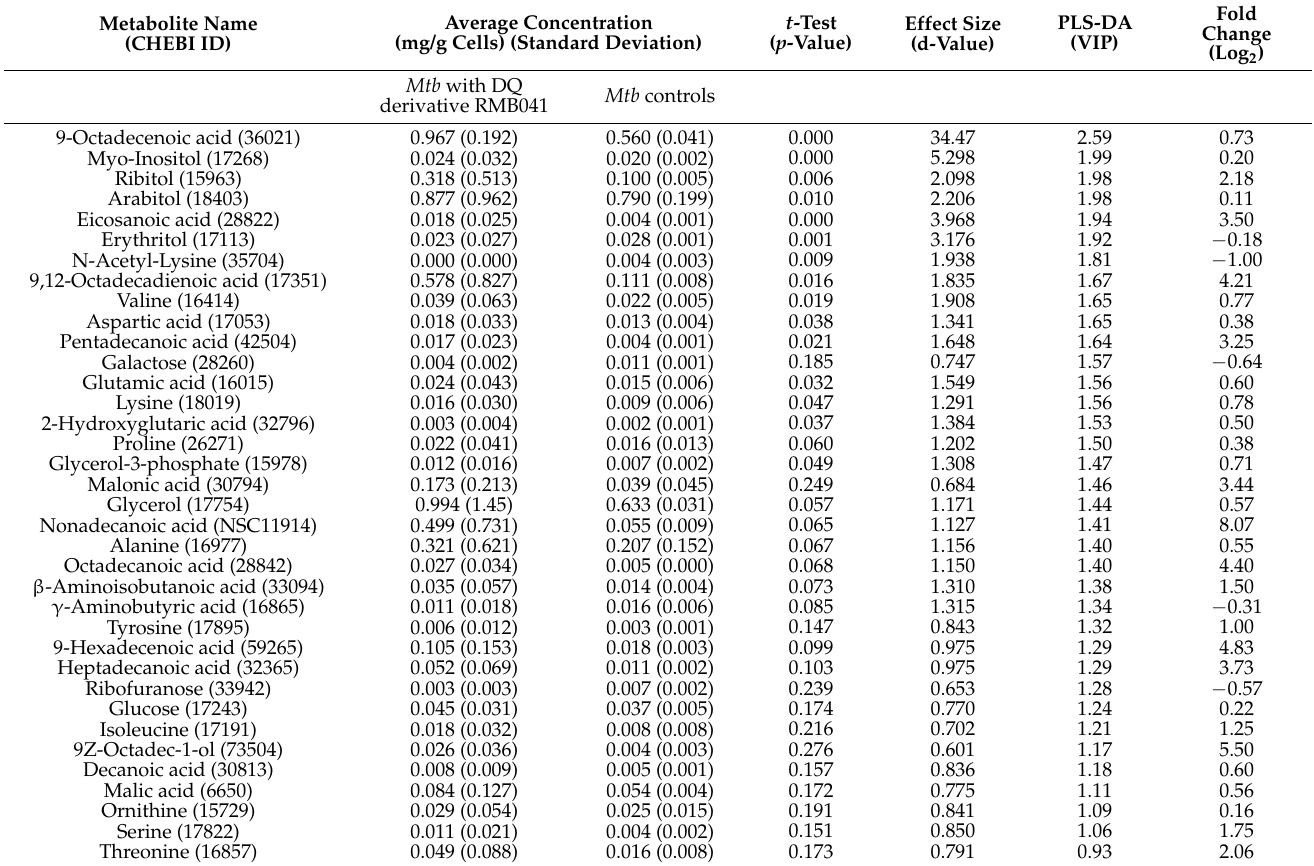
Table 1. The selected metabolite markers best describing the variance between the metabolome of Mtb cultured in the absence ( Mtb controls) and presence of DQ derivative